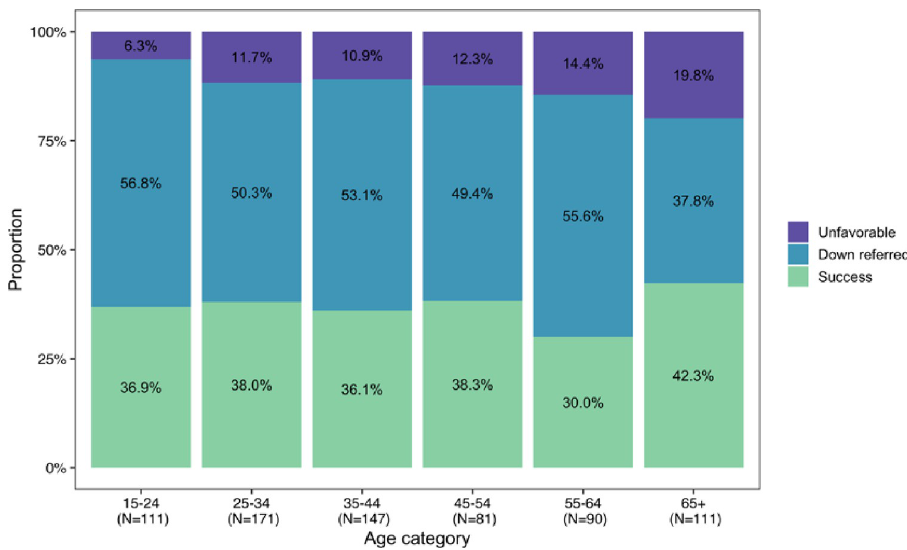
Fig 2. TB treatment outcomes by age group (N =